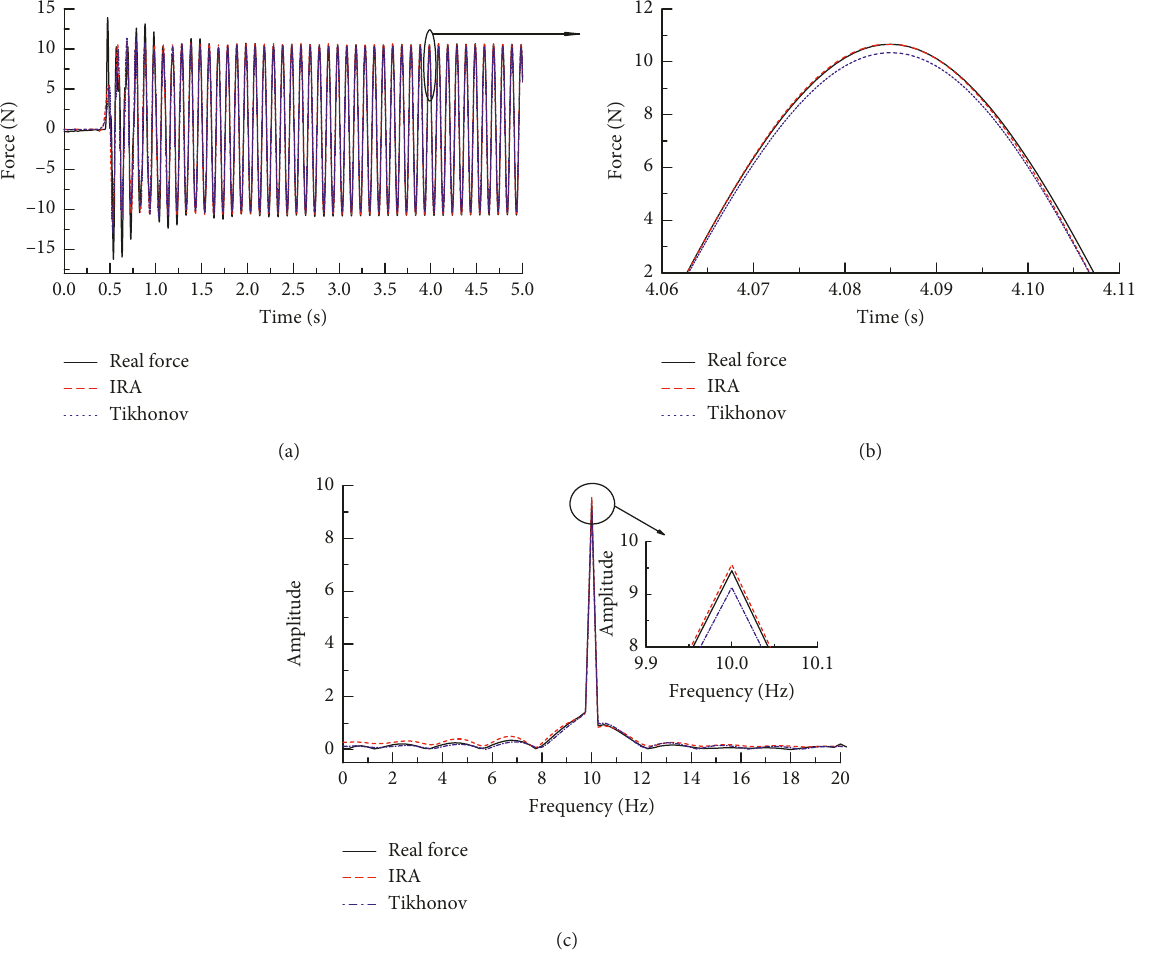
Figure 13: Identified result of the harmonic loads and its frequency